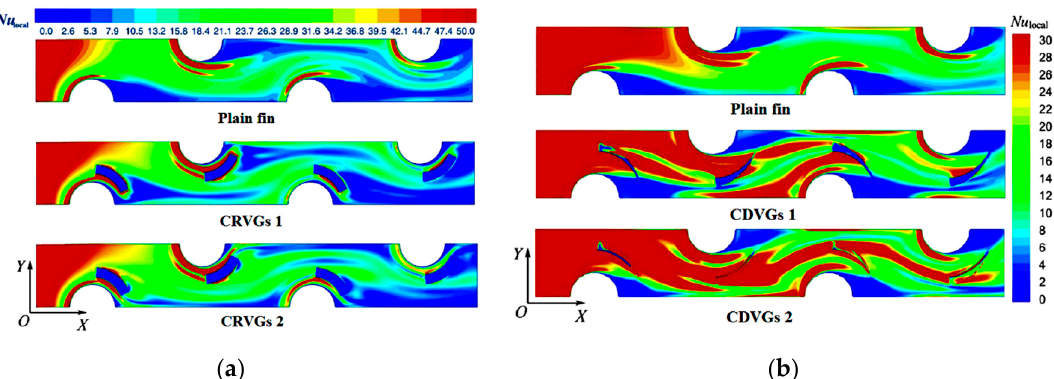
Figure 13. Comparison of Nu distribution on fins with curved VGs [16,104]. ( a ) With curved RWPs. ( b ) With curved DWPs. CRVGs: curve rectangular vortex generators; CDVGs: curve delta vortex generators.